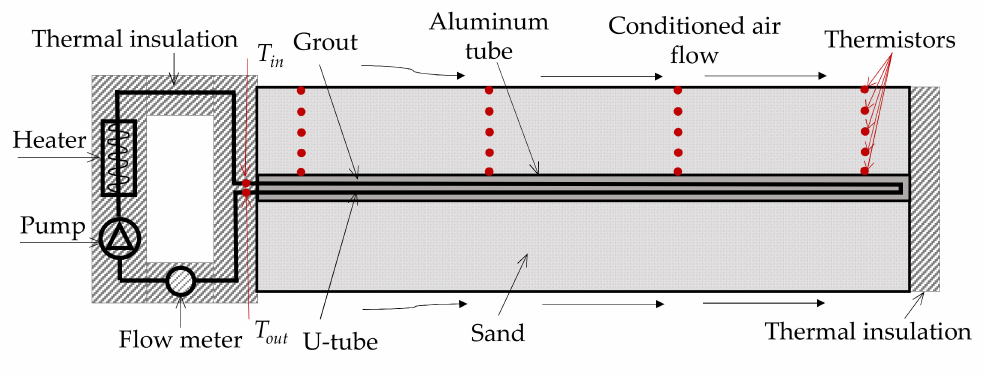
Figure 1. Scheme of the experimental